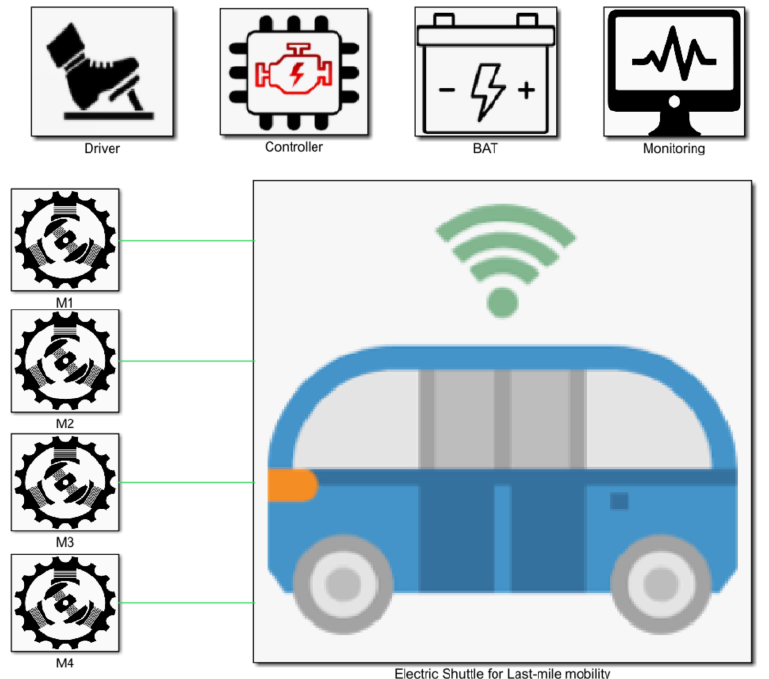
Figure 14. Simulation model: M1 to M4: In-wheel Motor.